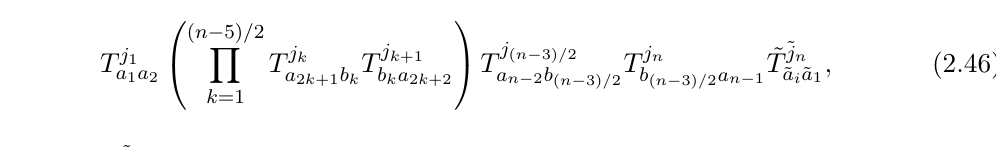
Figure 6 . The general flavor factor for M NLSM + φ + ψ these are not Feynman diagrams, but only represent the flavor structures of the associated ordered amplitudes. The thin lines are for the group H of the left ordering, while the thick lines are for the group ˜ H of the right